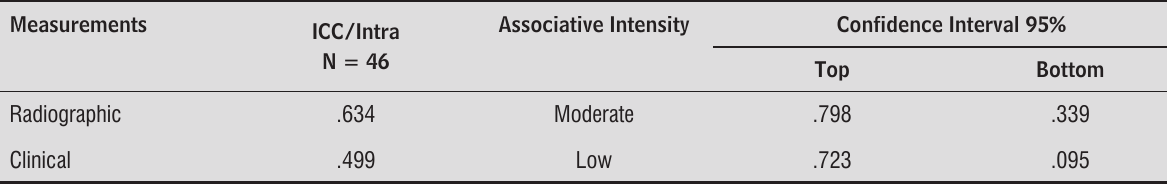
Table 3 - Inter-examiner reliability obtained through the